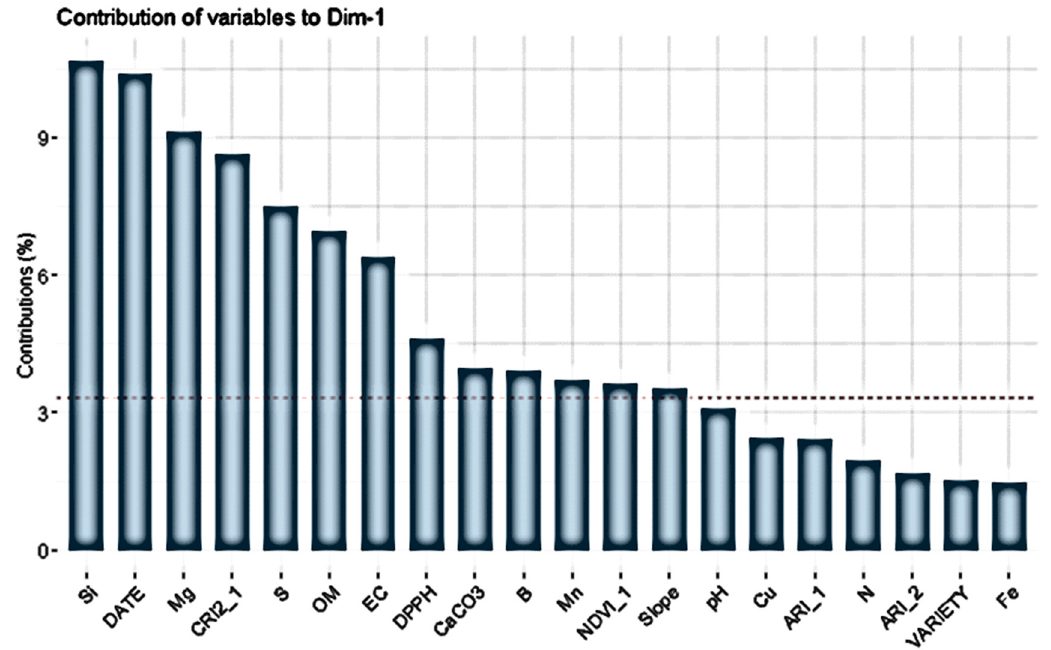
Figure 5. Variable contribution plot showing the 20 top variables contributing to the first principal component. The dashed line on the graph indicates that a variable with contribution larger than this cut-off could be considered as important contributing variable to the component, as determined using the dimdesc function in R.